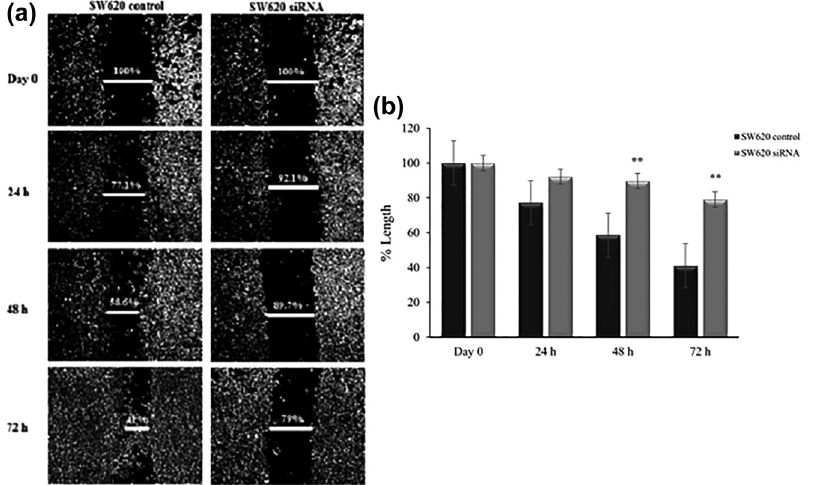
Figure 5: The migration of clusterin-silenced SW620.